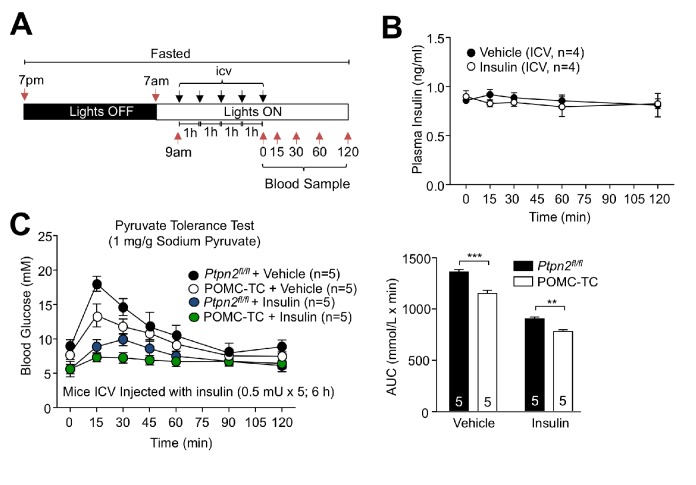
Effects of central insulin administration in POMC-TC mice on glucose metabolism.(a–b) 8-week-old male C57BL/6J mice were fasted overnight and administered ICV saline or insulin (0.1 mU/animal, 5 injections over 5 hr) as indicated in (a) the schematic and (B) blood sampled at 0, 15, 30, 60 and 120 min post-injection and plasma insulin levels determined. (c) 8–10 week-old Ptpn2fl/fl or POMC-TC overnight fasted male mice were ICV administered saline or insulin (0.5 mU/animal, 5 injections over 5 hr) and subjected 1 hr later to pyruvate tolerance tests (1 mg/g); areas under curves were determined and significance was determined using a two-way ANOVA followed by Sidak multiple comparison test.